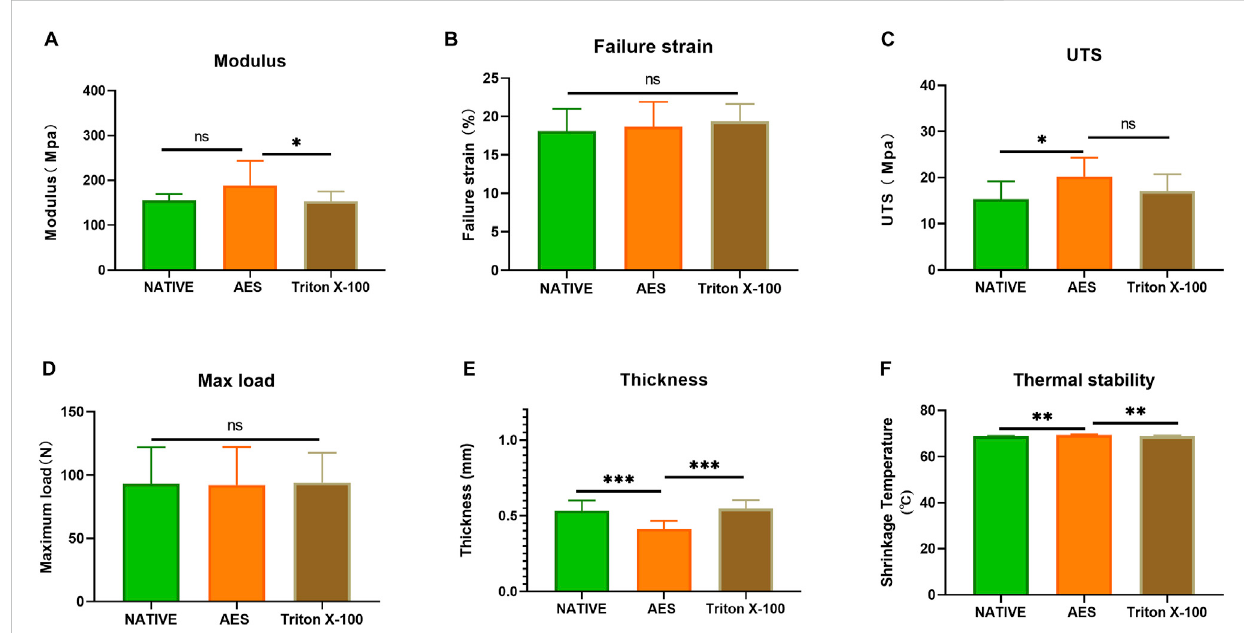
FIGURE 4 Mechanical performance of each sample (A) Young ’ s modulus; (B) Failure strain; (C) The ultimate tensile strength (UTS); (D) Max load. (E) Thickness (n=12;* p < 0.05;** p < 0.01;*** p < 0.001;nsrepresentsnosigni fi cantdifference); (F) shrinkagetemperature(n=5;* p < 0.05;** p < 0.01;*** p < 0.001;ns represents no signi fi cant difference).